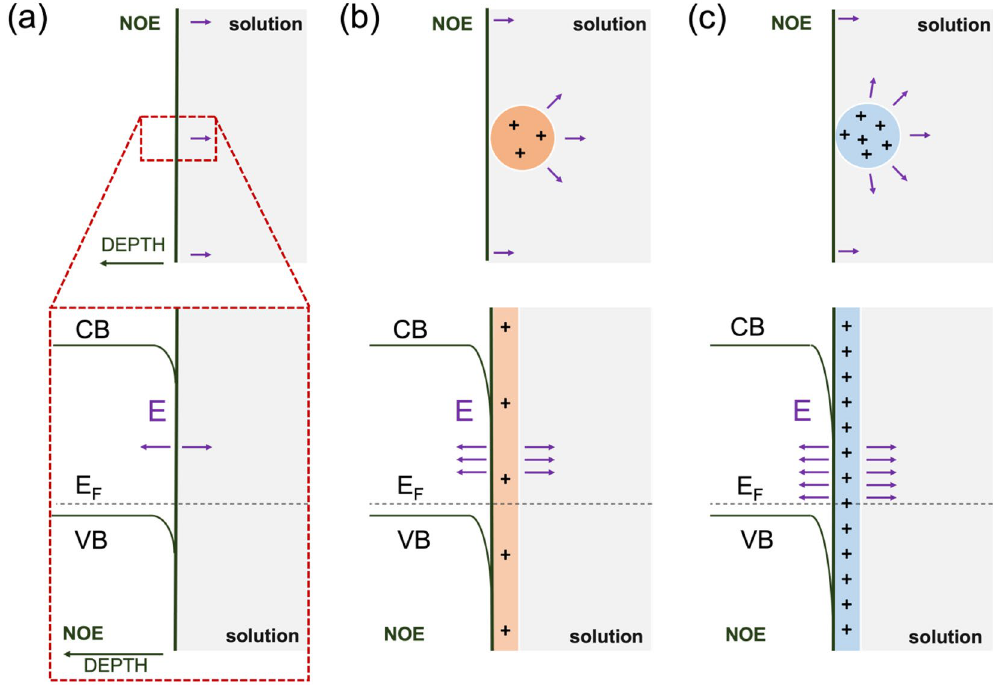
Figure 5. Scheme of energy band bending and local electric field E for ( a ) bare, ( b ) Au (or Pd), and ( c ) Au@Pd decorated electrode at solid–liquid